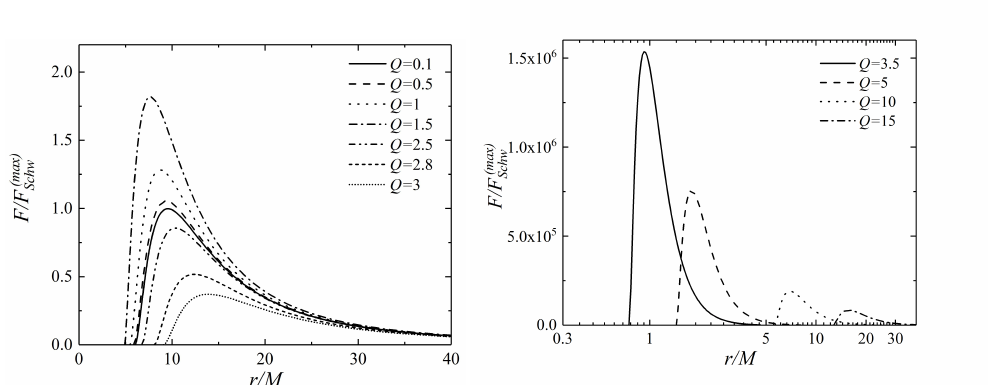
Figure 10. The normalized flux ( M = 4) from inner ( right ) and outer ( left ) parts of